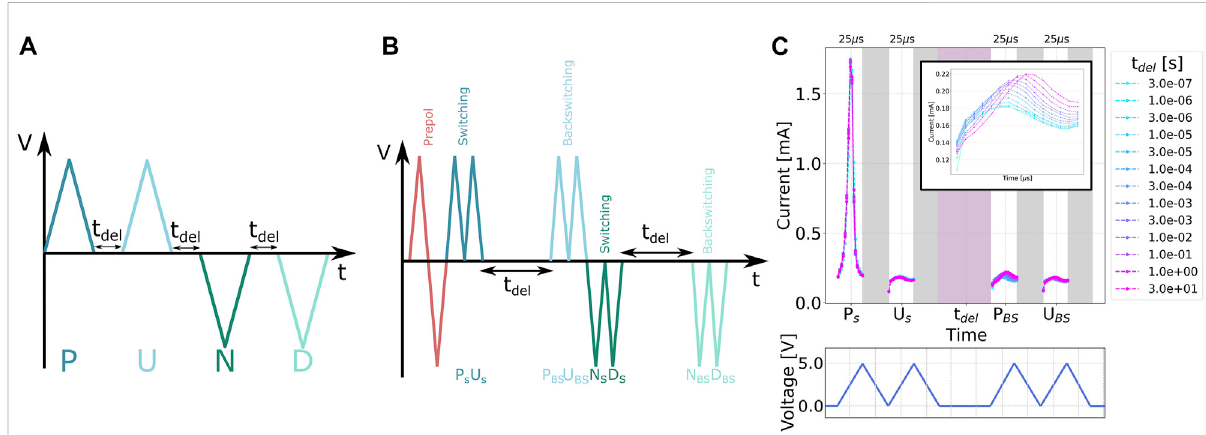
FIGURE 1 (A) Standard PUND (Positive Up, Negative Down) pulse train for characterization of ferroelectric fi lms; (B) pulse train for measuring polarization loss in ferroelectric thin fi lms; (C) example of the current trace recorded when measuring the (P loss ) at different delay times. The backswitched current pulse in positive polarity (P BS ) is shown on a smaller scale in the